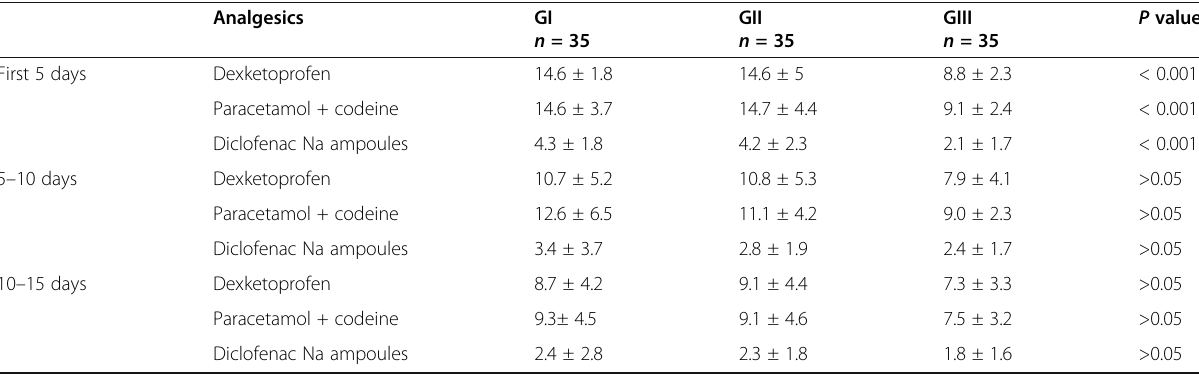
Table 4 Postoperative pain in the studied groups